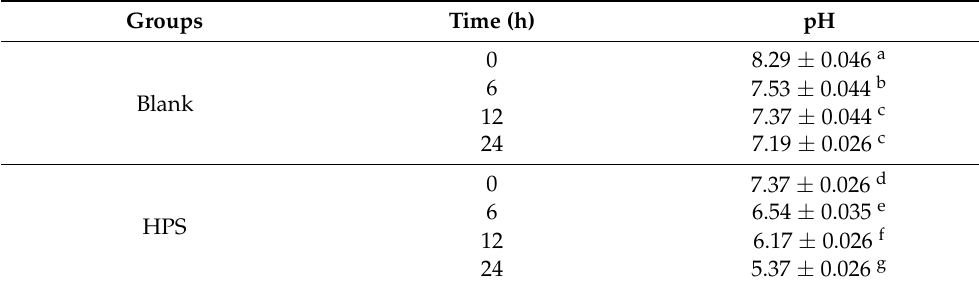
Table 2. Changes in pH during the fecal fermentation of HPS.